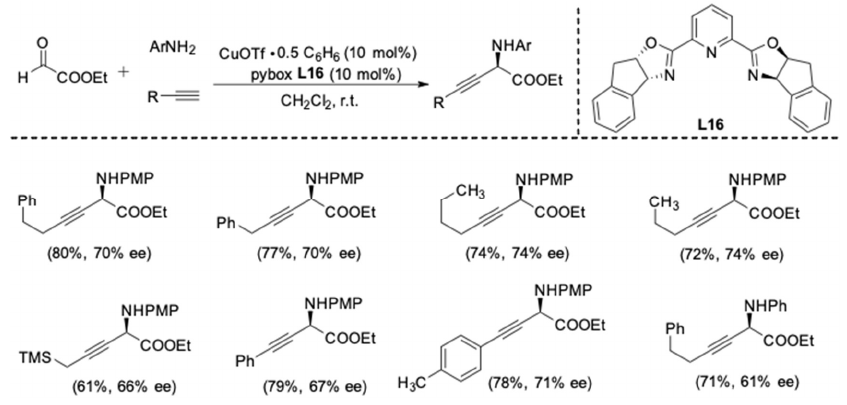
Figure 9. Asymmetric three-component reactions of ethyl glyoxylate.